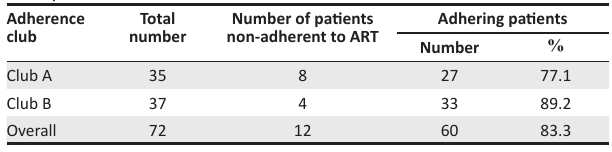
TABLE 5: Adherence to medication distribution rates in two adherence clubs at Facility